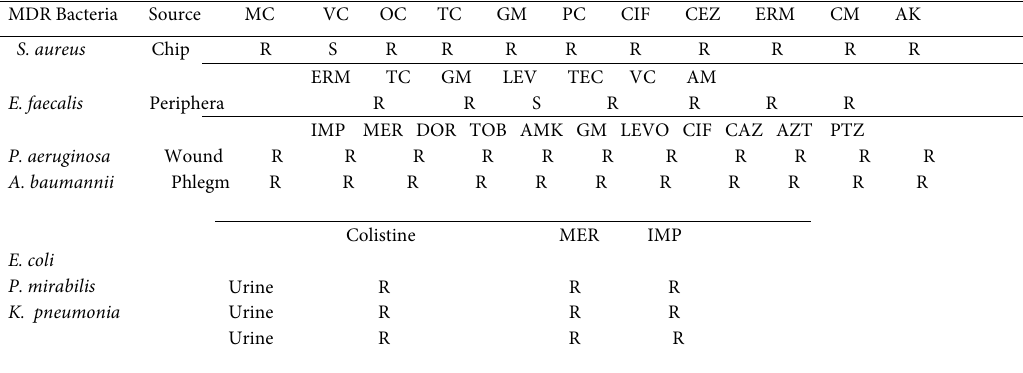
Table 2. Antibiotic resistance of the bacterial isolates from chip, urine, peripheral, wound and phlegm.